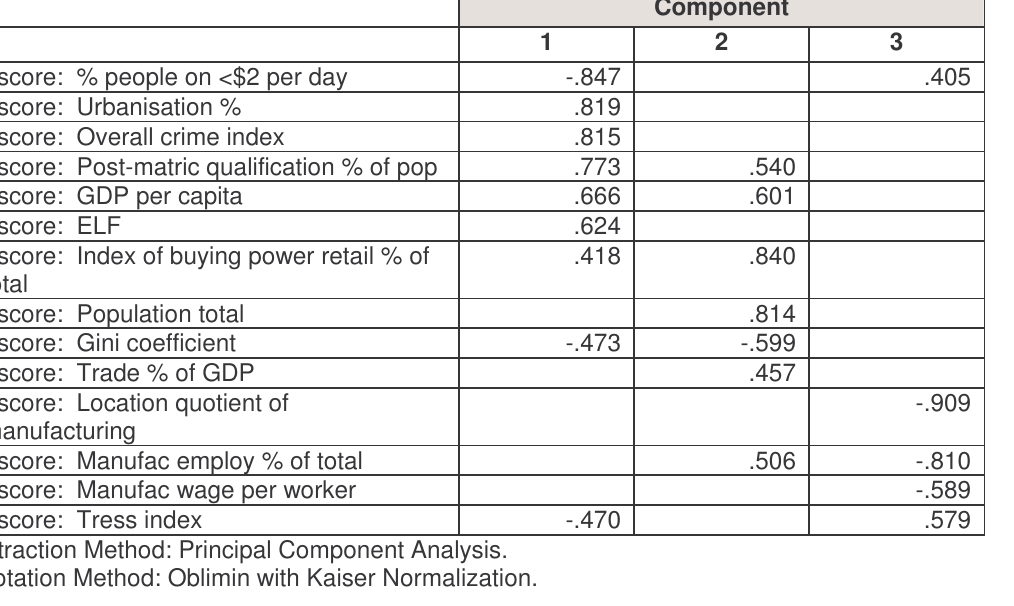
Table 5: Structure matrix